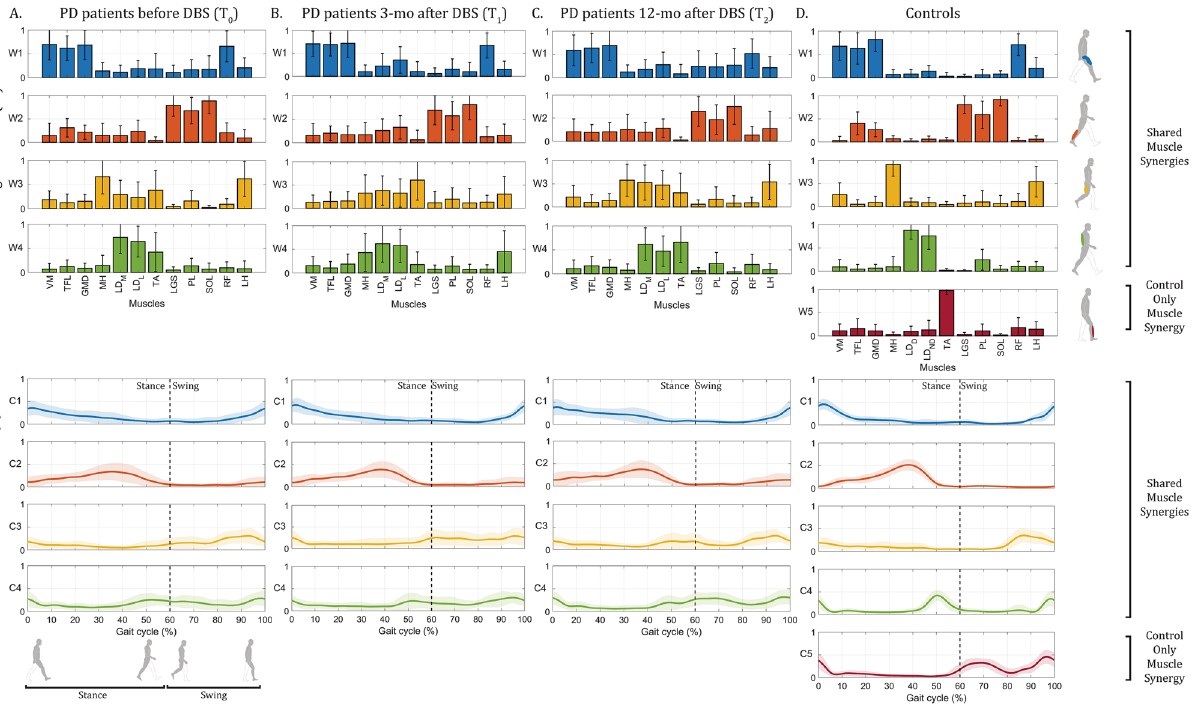
Figure 1. Comparison of muscle synergies extracted during walking from ( A ) PD patients before DBS (T 0 ), ( B ) PD patients 3 months after DBS (T 1 ), ( C ) PD patients 12 months after DBS (T 2 ), and ( D ) controls. For each synergy k , the weight vector W k (bars showing the muscles’ contribution levels) and the corresponding activation coefficient C ( t ) k (time profile of the neural command) are displayed with the same color (average and standard deviation across the population are displayed). Vertical dotted lines represent the transition between the stance and the swing phase of the gait cycle. Muscle abbreviations: VM vastus medialis, TFL tensor fasciae latae, GMD gluteus medius, MH medial hamstring, LD longissimus dorsii (for PD patients: LD M ≡ LD of the more affected side, LD L ≡ LD of the less affected side; for controls: LD D ≡ LD of the dominant side, LD ND ≡ LD of the non-dominant side), TA tibialis anterior, LGS lateral gastrocnemius, PL peroneus longus, SOL soleus, RF rectus femoris, and LH lateral